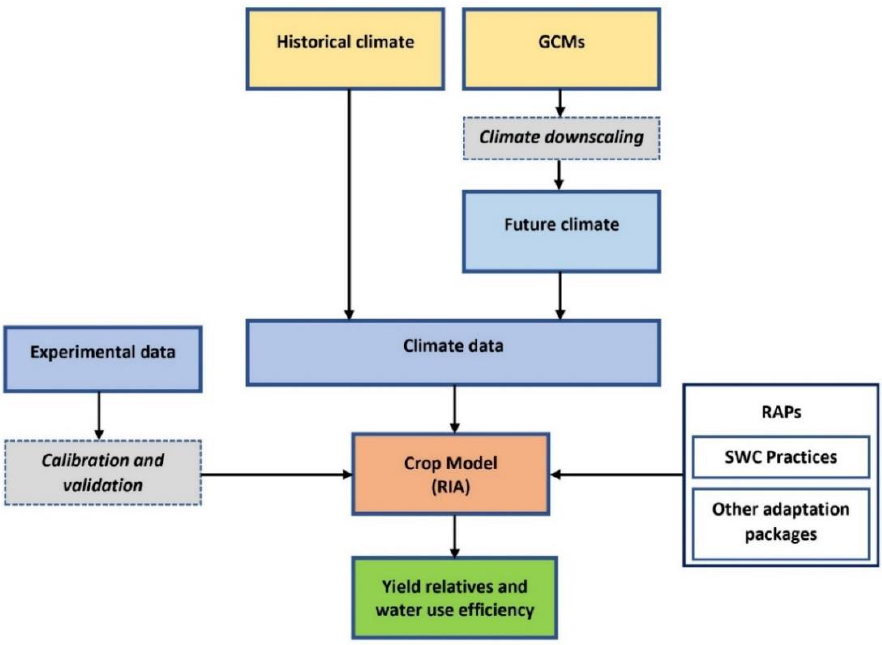
Figure 1. The Regional Integrated Assessment Approach development framework used in the study.